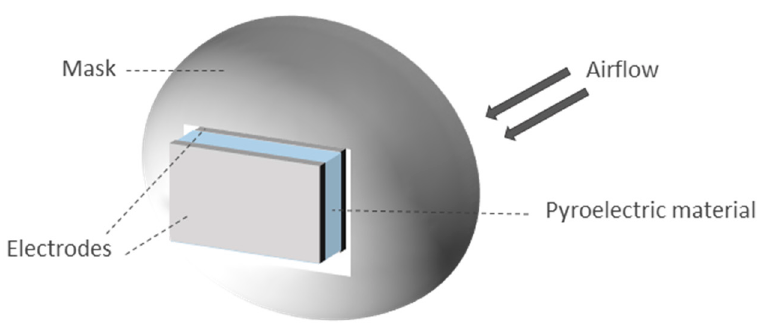
Figure 17. Schematic of a pyroelectric energy harvester using a mask-mounted breathing prototype (figure inspired by Reference [253]).